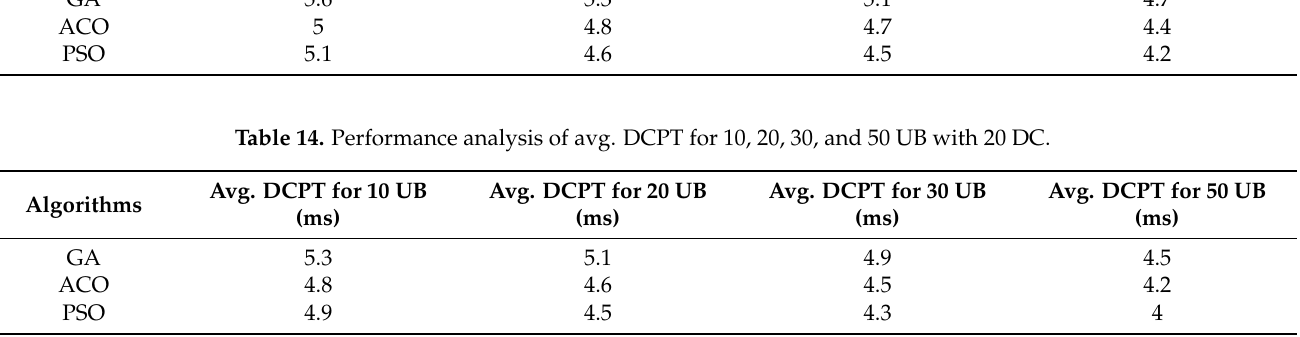
Table 13. Performance analysis of avg. DCPT for 10, 20, 30, and 50 UB with 15 DC. Algorithms